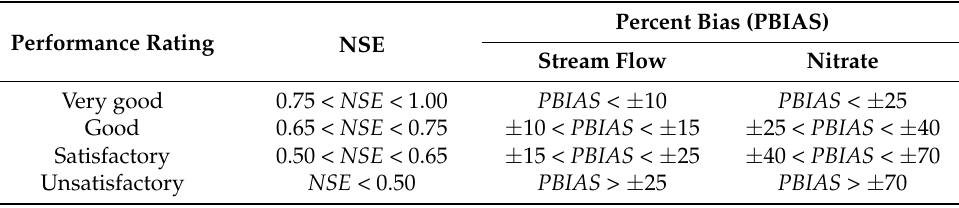
Table 2. General performance for recommended statistics at a monthly time step